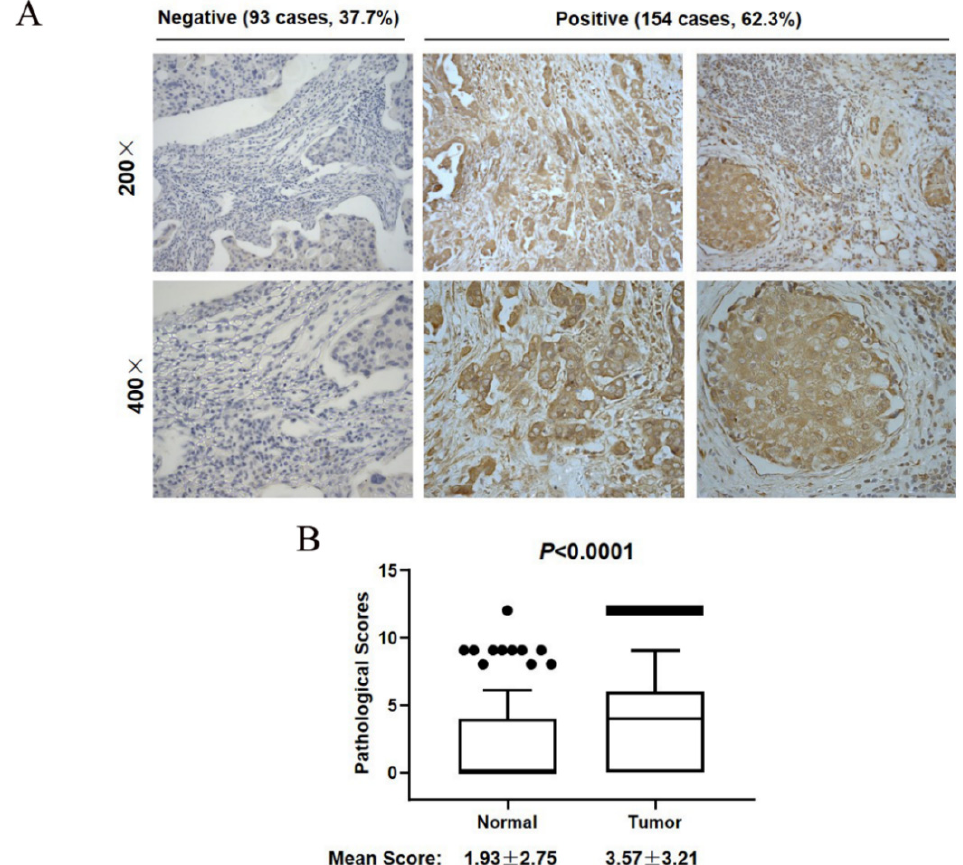
Figure 2. SCYL1 is highly expressed in breast cancer. ( A ) IHC staining of SCYL1 in BC tumor samples.